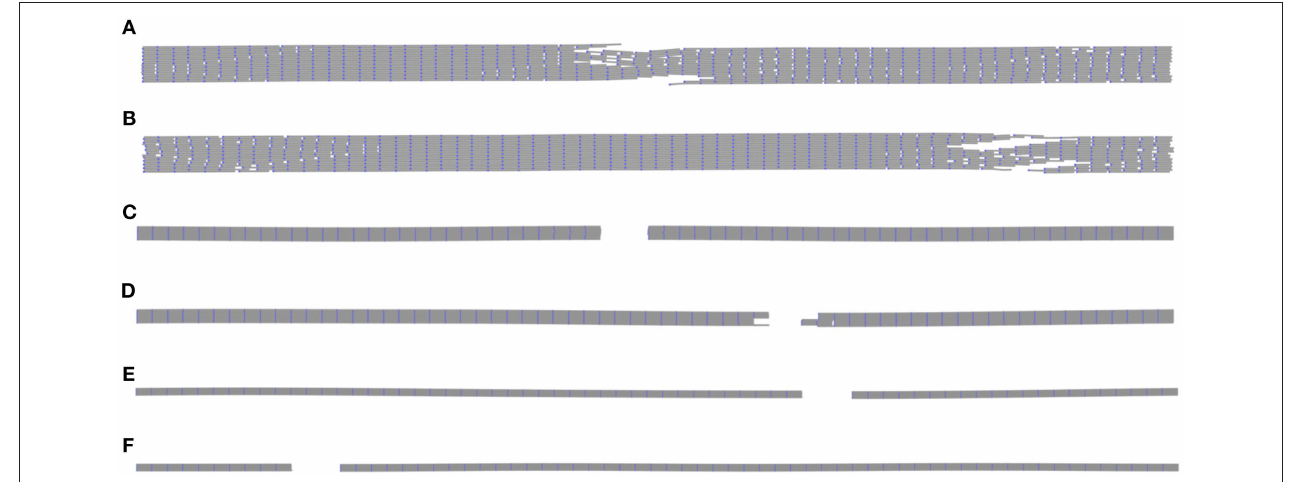
FIGURE 11 | Deformed configurations of (A,B) L = 50nm, (C,D) L = 150nm, and (E,F) L = 300nm size scaled CNC films with 32 CNC fibers in series.